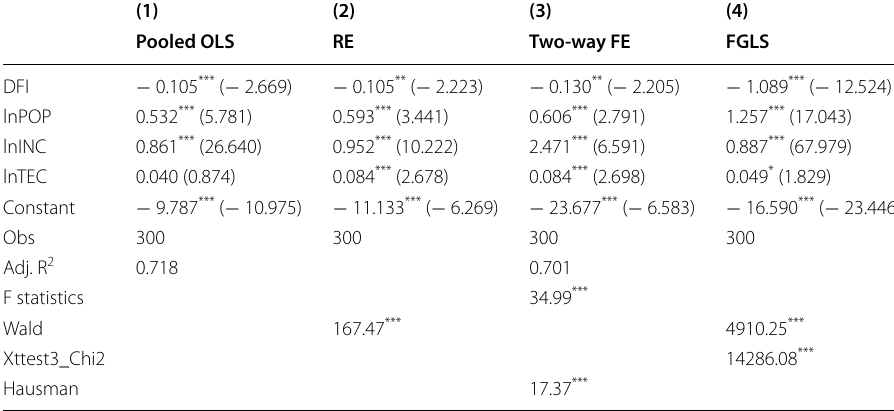
Table 4 The results of baseline